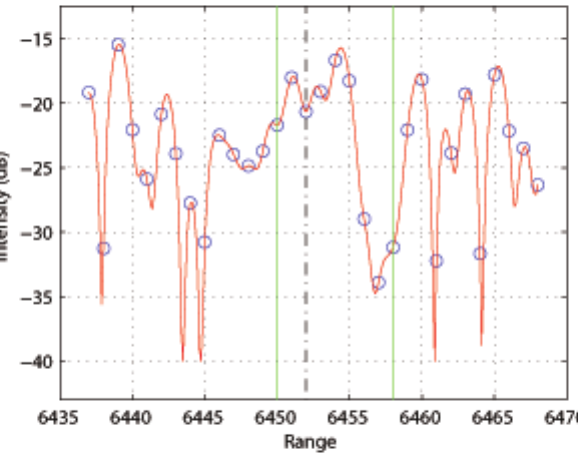
Figure 9. Corner reflector (HV + VH)/2 response